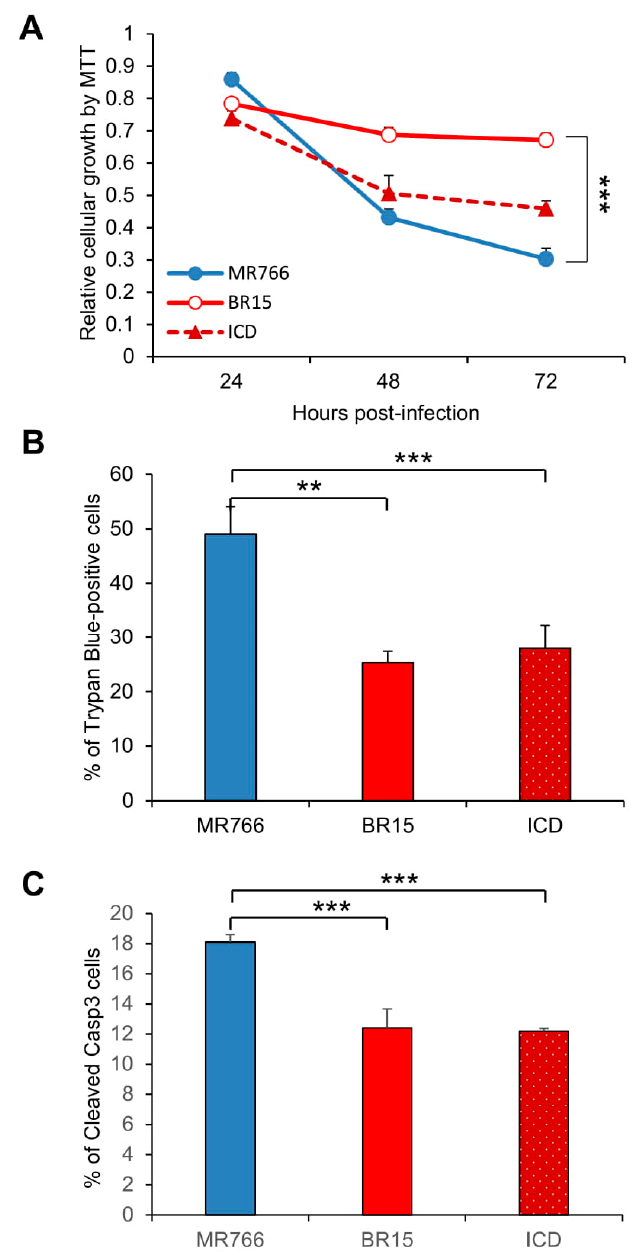
Figure 2. Different neuro-cytopathic effects of epidemic and historical molecular clones of Zika viruses on human brain glial SNB-19 cells. ( A ) Cellular survival was measured by the MTT assay. The graph is plotted as the relative growth in relevance to mock infected SNB19 cells. Statistic t-test shows that the differences among three viruses are not statistically significant. ( B ) ZIKV-induced cell death as measured by the Trypan blue assay. **, p < 0.05 for BR15 and ***, p < 0.01 for ICD. Three different experiments were carried out. Average cell number counted was about 100–200. ( C ) ZIKV-induced apoptosis was measured by caspase-3 cleavages using immunostaining as reported previously [32]. Cells were collected at 72 h p.i. Two experiments were conducted and cells showing caspase-3 cleavages were counted at 10 different areas with an average number of cells counted at 25–75. All results represent average and standard deviation (X + SD). Levels of statistical significance were calculated by Two-way ANOVA for ( A ). The difference between MR766 and BR15 is highly significant with p < 0.01 (***).